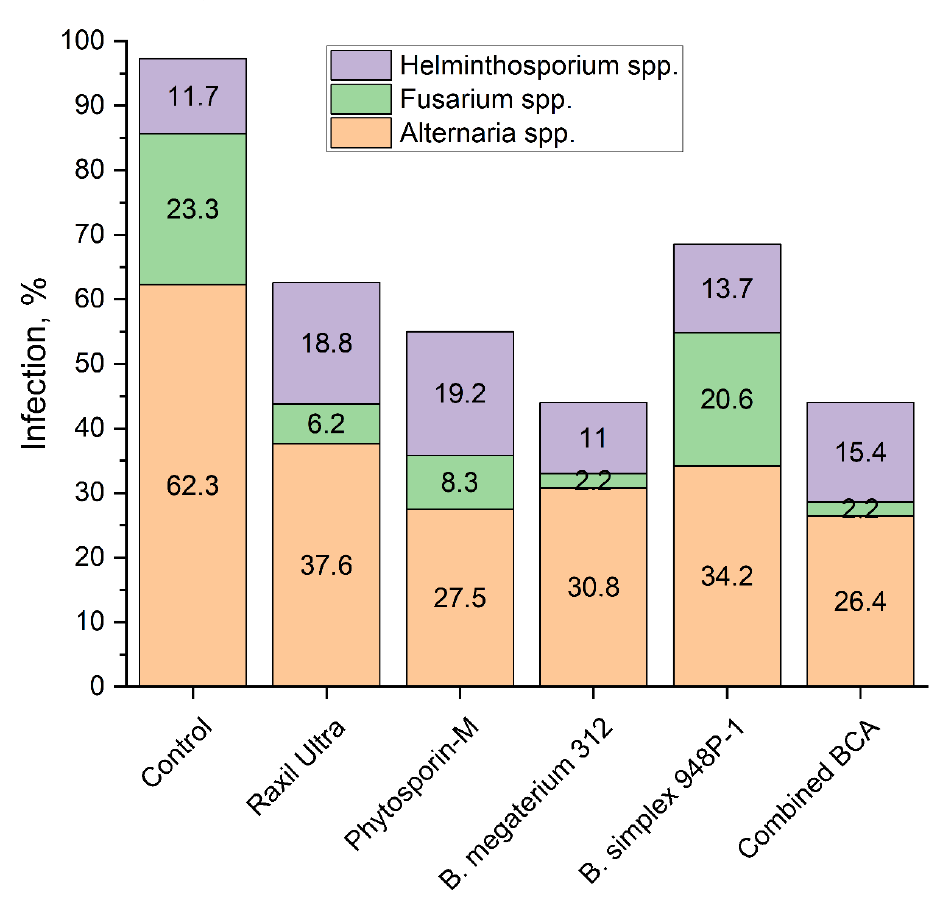
Figure 3. Damage to seeds of the first generation of winter wheat Triticum aestivum L. The infection rate of winter wheat grain with Helminthosporium spp. ranged For phytosanitary control, we used seeds (first generation) that were obtained by growing wheat seeds of Triticum aestivum L, treated (zero generation) with the studied Bacillus spp. strains. The evaluation of seed infestation was carried out via microscopic examination (n = 100).